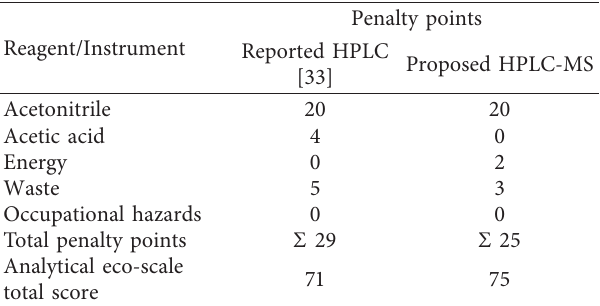
Table 3: Penalty points of the reported HPLC method and the proposed HPLC-MS